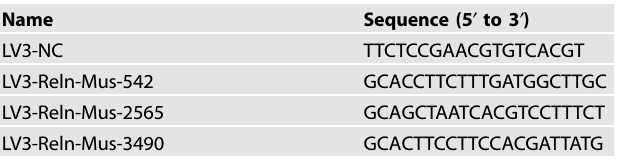
Fig. 6 Reelin knockdown promoted osteoblast differentiation and osteogenesis. We isolated osteoblasts from limb bones and explored Reelin ’ s impacts on bone formation ( n = 6 per group). A Representative Alizarin Red staining (upper panel) and ALP staining (lower panel) images showing osteoblast activity. B mRNA and protein expression of osteoblastogenic genes examined by RT-PCR and western blotting respectively. Reln stands for Reelin. ** p < 0.01 vs. Control group; ## p < 0.01 vs. SP2/0 group. Table 1. Targeted sequences of Reelin by